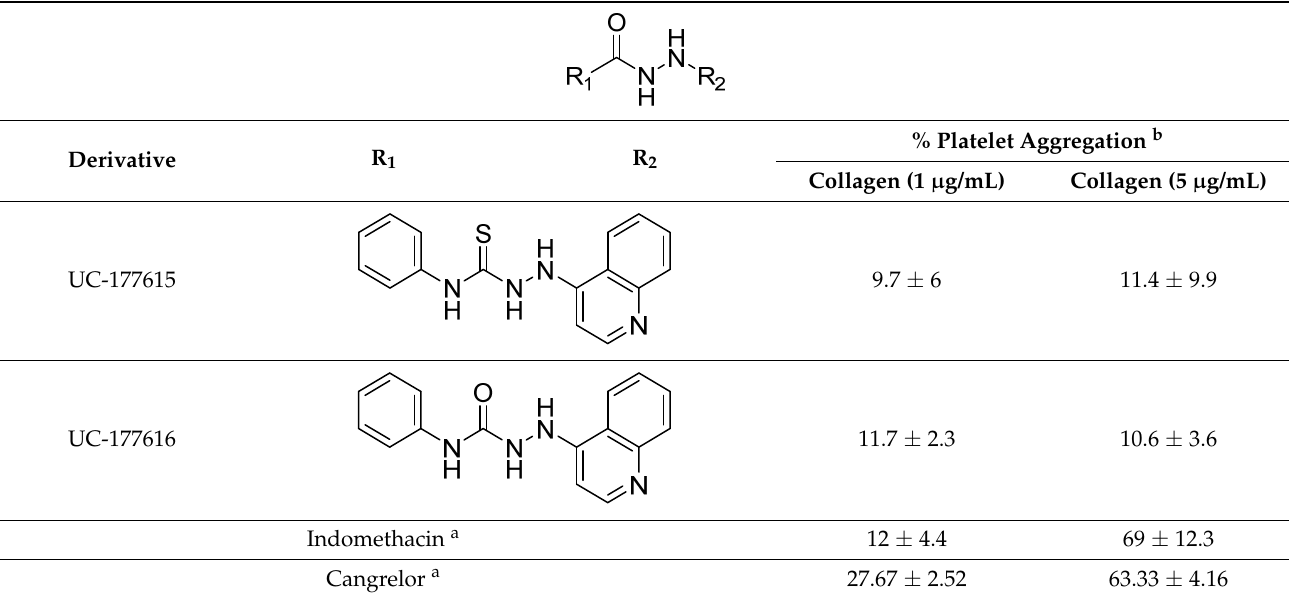
Table 2. Structures of compound UC-177629 analogs and their effects at 20 µM on in vitro collagen- Table 2. Cont. induced platelet